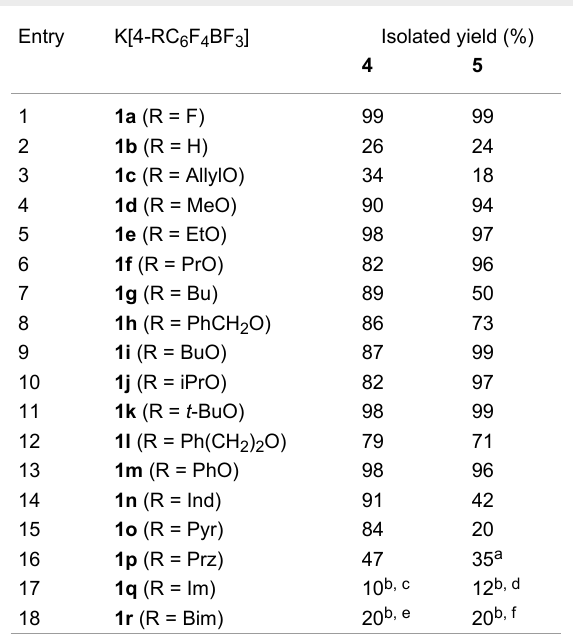
Table 1: Preparation of biphenyls 4a–r and 5a–r